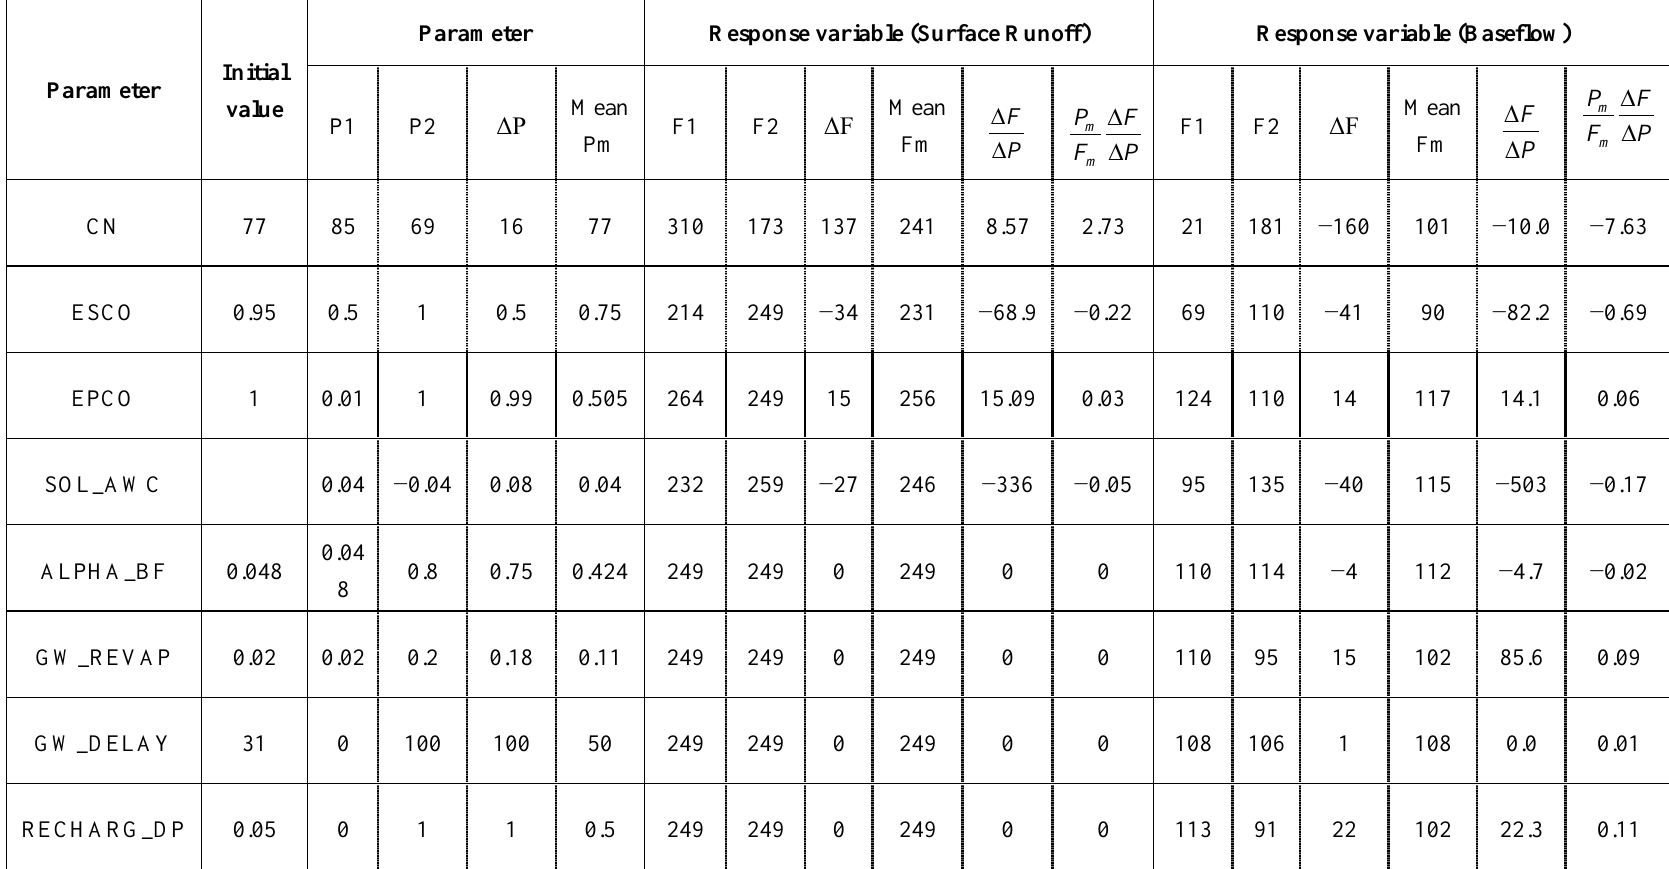
Table 2. Sensitivity indices of model